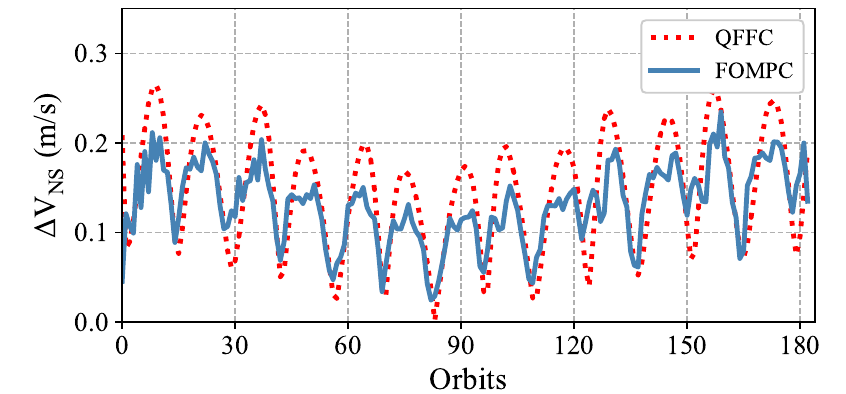
Figure 7. The half-year time histories of ∆ V NS for the QFFC and the